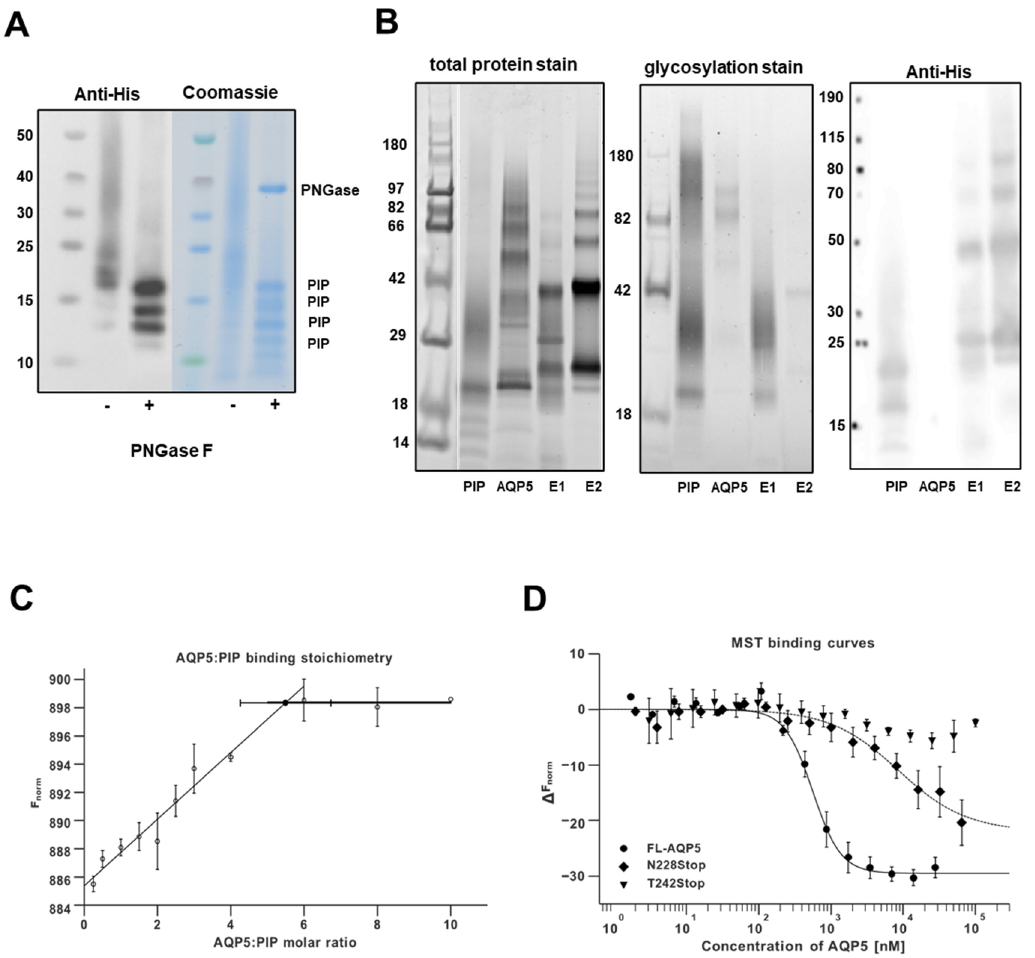
Figure 3. AQP5 and PIP interact at molecular levels. ( A ) WB and SDS-PAGE gel of PIP before and after deglycosylation. ( B ) SDS-PAGE and WB of E1 and E2 samples from the co-elution assay. ( C ) MST binding curves for PIP binding to AQP5 constructs (n = 3). ( D ) Stoichiometry analysis of FL-AQP5 binding to PIP (n = 2). Results are expressed as the mean ± S.E.M.